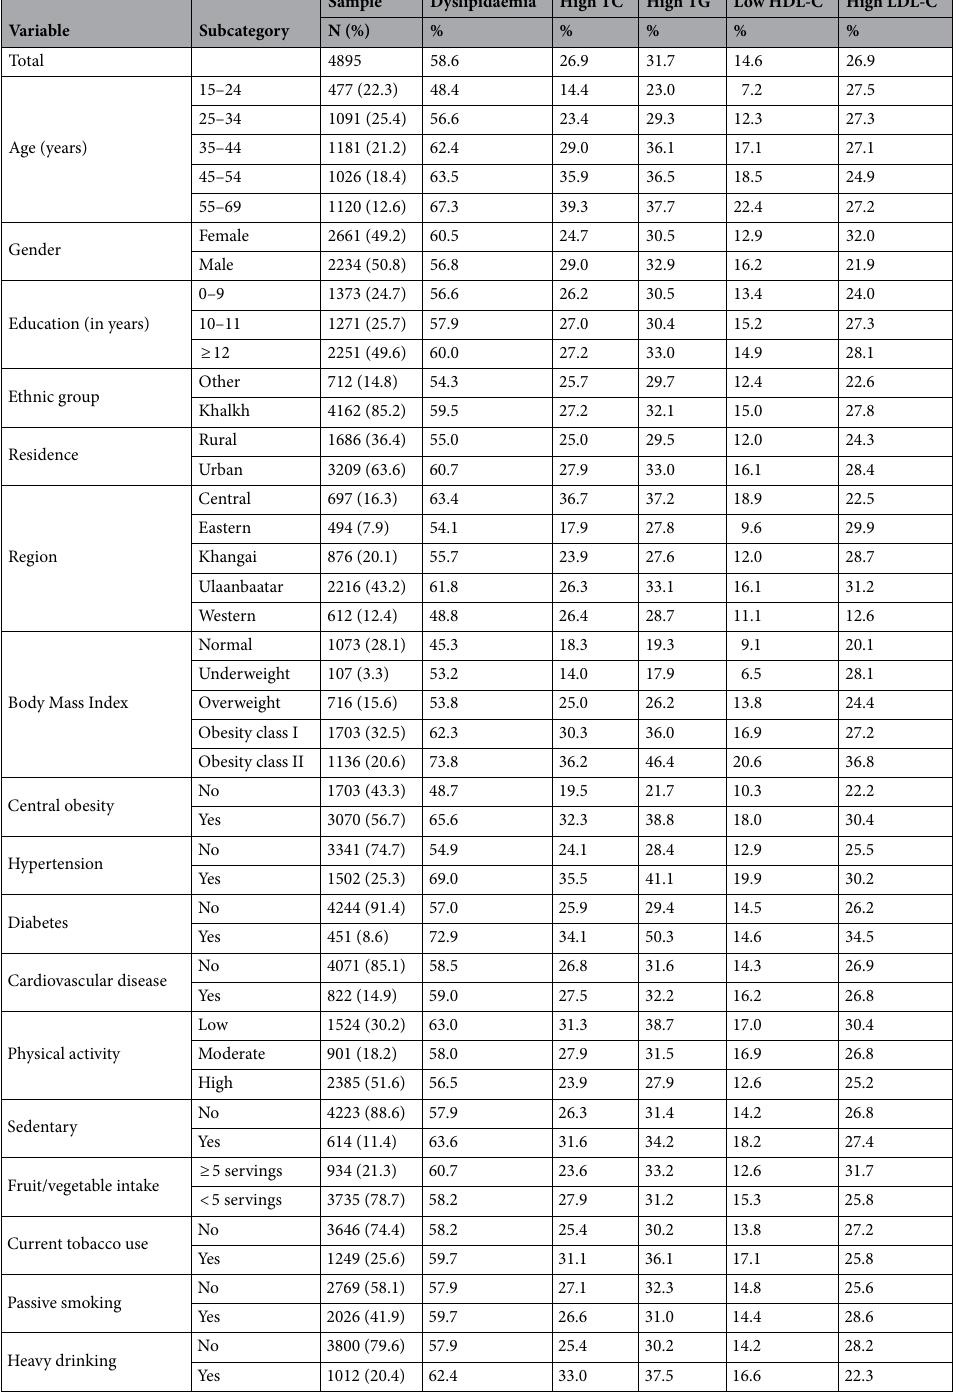
Table 1. Sample description and prevalence of dyslipidaemia and its subtypes, Mongolia